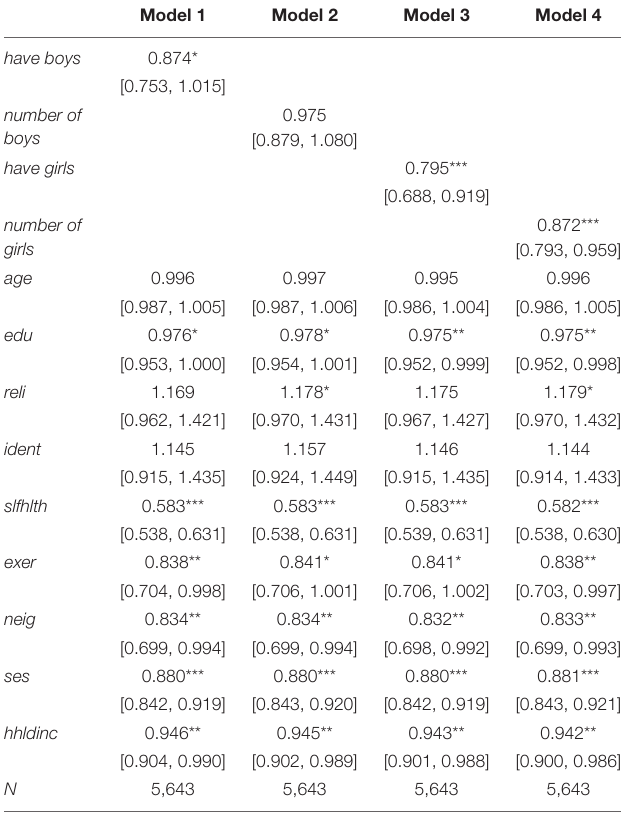
TABLE 4 | Estimates of heterogeneity analysis: gender of the child.